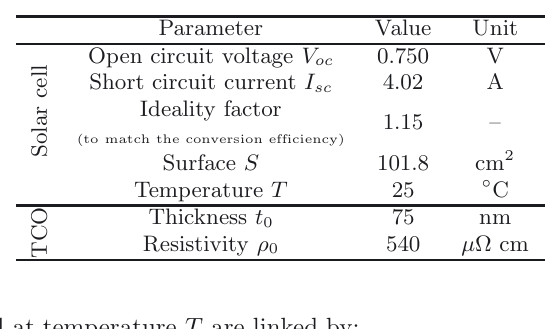
Fig. 9. Relative degradation of the conversion efficiency for an ideal efficient solar cell (see Tab. 3). Only the front series resistance is taken into account to calculate the conversion ef- ficiency degradation. White lines are contour